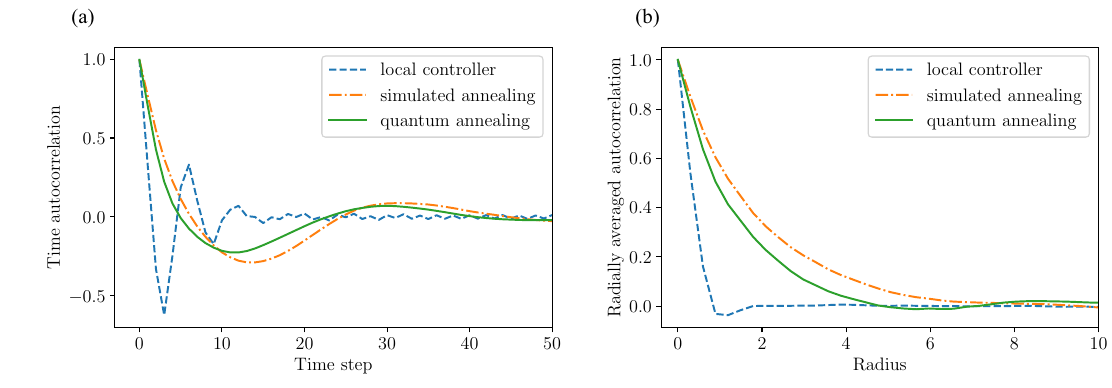
Figure 6. Time and spatial autocorrelation functions for different control methods. ( a ) Time autocorrelation function and ( b ) Radially averaged spatial autocorrelation function. Parameters α , η , and L are fixed as α = 0.8, η = 1.0 , and L = 50 , respectively.